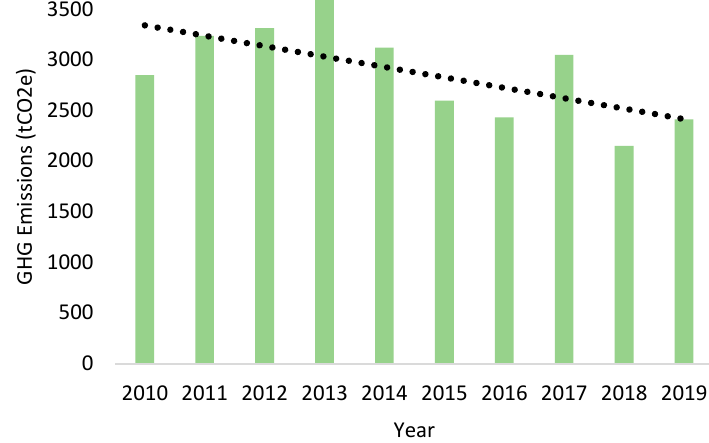
UBCO is mandated by law to submit a yearly GHG emission inventory report. The emissions in this report include scope 1 and scope 2 GHG emissions and any offsetable emissions. These emissions include emissions from the energy used in buildings, fleet transportation, paper, and fugitives. A historic layout of the emission from UBCO is illustrated in Figure 7 [91].